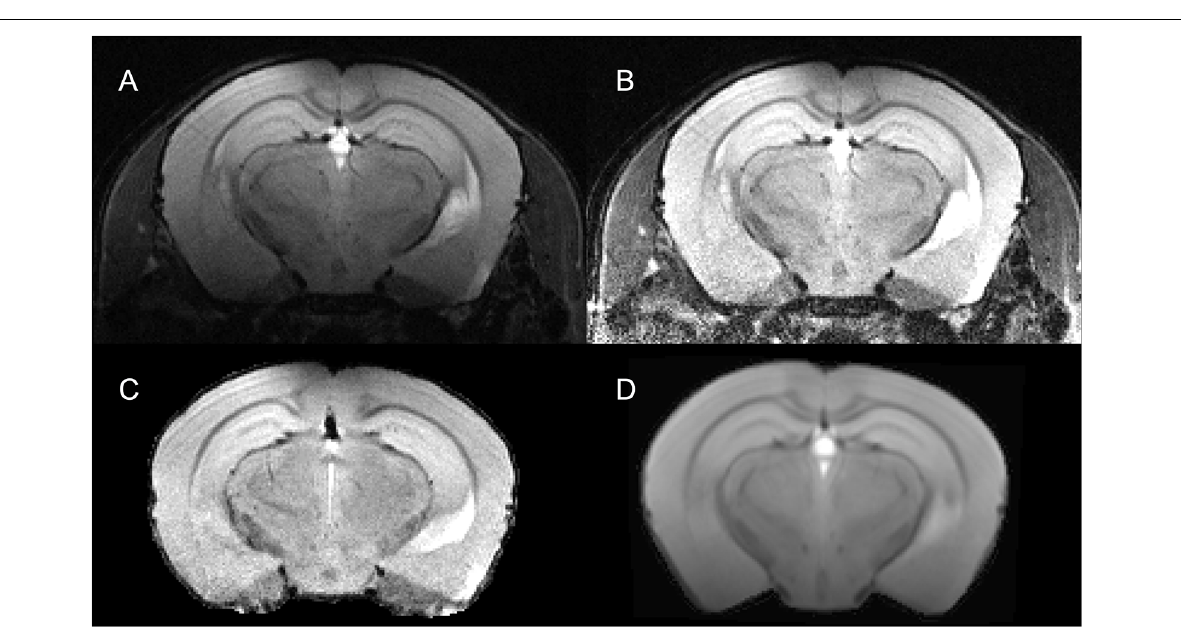
FIGURE 2 | Visualization of step 2—pre-processing for a representative T2-weighted data set. The raw data set I T 2 ( x ) (A) underwent a re-orientation f re ( x ) and bias field correction using multiplicative intrinsic component optimization (MICO) f bc ( x ) to reduce inhomogeneities (B) . The subsequent registration is done on a brain extracted volume I T 2 ex ( x ) (C) by deforming the MTPL I T ( x ) (D) with affine f A ( x ) and non-linear f NL ( x )